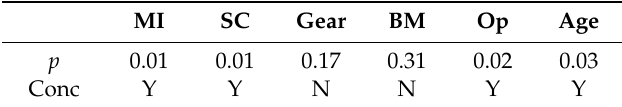
Table 2. Fisher’s exact test, to determine if characteristics of accidents with maintenance contributions are di ff erent to an expected uniform distribution. MI